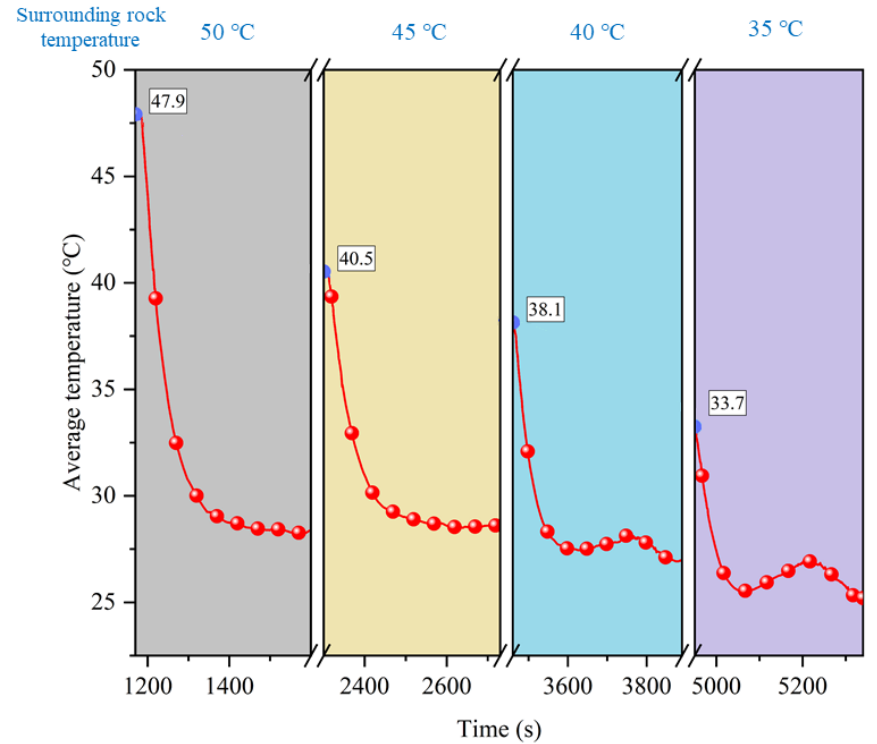
Figure 10. Cooling effect at different surrounding rock temperatures.